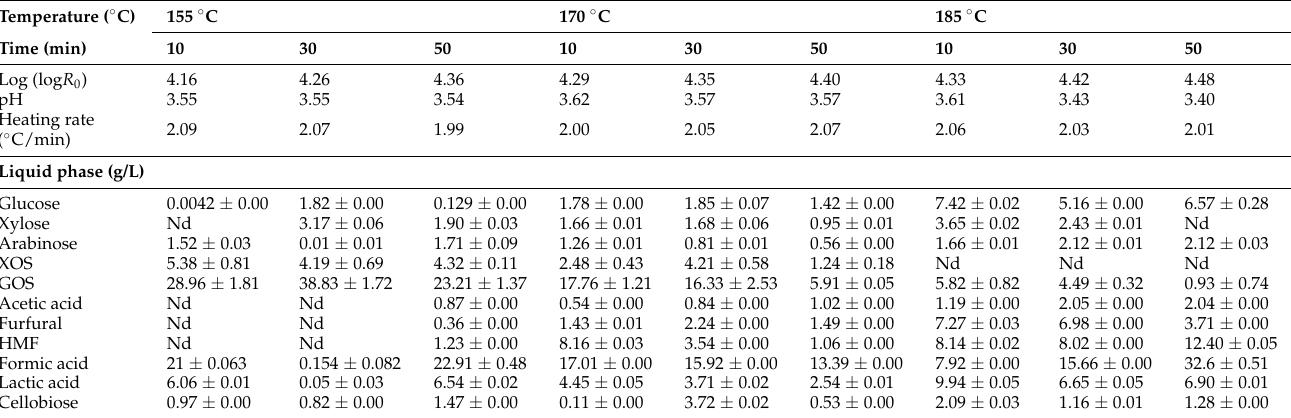
Table 1. Experimental conditions evaluated in the hydrothermal pretreatment on liquid phase of (SDR). Severity factor, pH, and heating